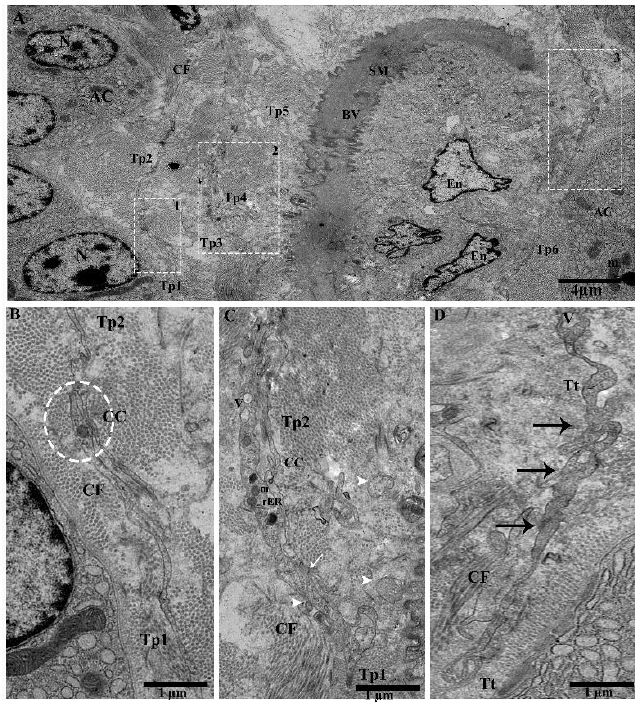
Figure 3. The connective tissue in between the lobules contains Tps around the large blood vessels, releasing extracellular vesicles and their tortuous processes, and beads on a string and close connections around the bend with blood vessels and the acinus can be observed. ( A ). Tps in the vicinity of blood vessels and adjacent to the acinus, scattered around and showing large prolongation. Square-marked areas 1, 2, and 3 in ( A ) are enlarged in ( B , C , D ), respectively. ( B ) Long cell process (Tp 1 , Tp 2 ), and close connections (junctions) between podoms to podomers and adjacent to the acinus. ( C ) In the vicinity of a dilated segment of Tp 1 , rough endoplasmic reticulum, mitochondria, dense bodies, vesicles, and close connections (podoms–podomers) with Tp 1 (white arrow) are visible. EVs (arrowheads) are present in connective tissue. ( D ) Tps contain a tortuous process, with many twists (beaded-like) (black arrows), along with collagen fibers and the acinus. Tp, telopodes; BV, blood vessel; SM, smooth muscle cells; En, endothelial cells; AC, acinus; CF, collagen fibers; V, vesicles; CC, close connection; Tt, tortuous; m, mitochondria; rER, rough endoplasmic reticulum; db, dense body. Scale bar = 4 µ m in (A); scale bar = 1 µ m in ( B – D ).